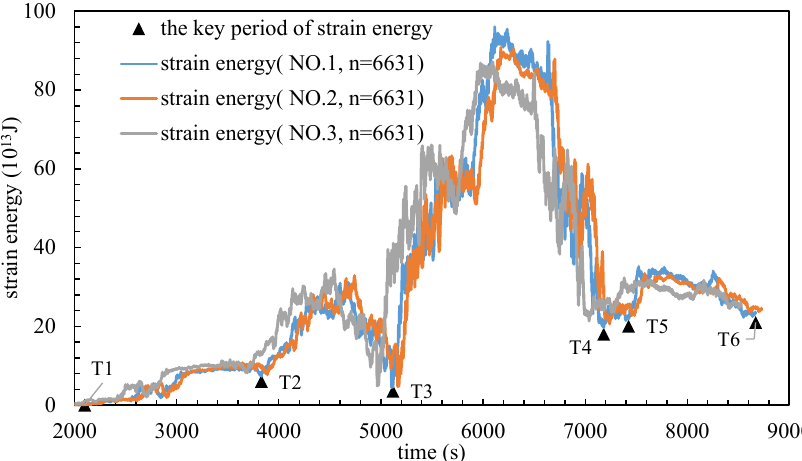
Figure 8. Strain energy over time of three repeated experiments, and the key period of strain energy.